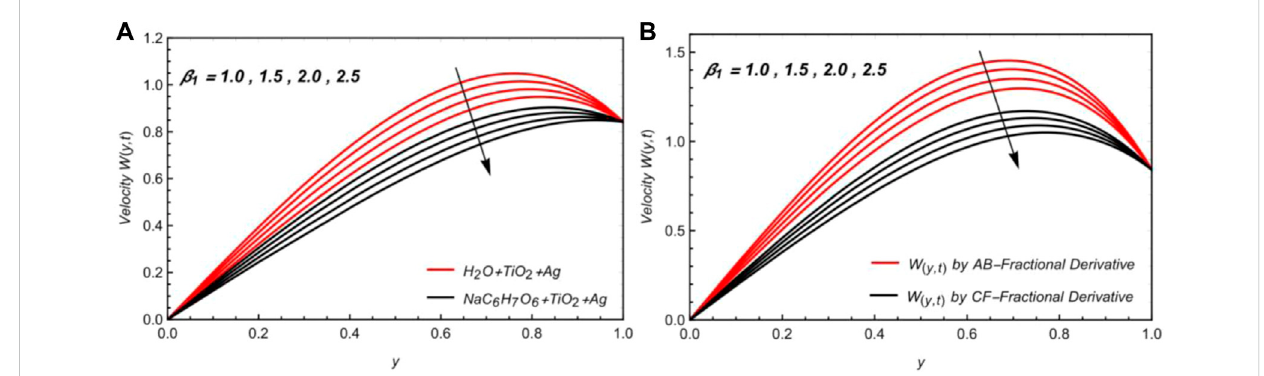
FIGURE 11 W ( y , t ) due to variation in β 1 with α , β (cid:2) 0 . 5 , φ (cid:2) 0 . 02 , M (cid:2) 1 . 65 , Ra (cid:2) 1 . 2 , K eff (cid:2) 0 . 7 , Gr (cid:2) 8 . 0 , Gm (cid:2) 6 . 3 , θ (cid:2) π /4 , and t (cid:2) 0 . 8.